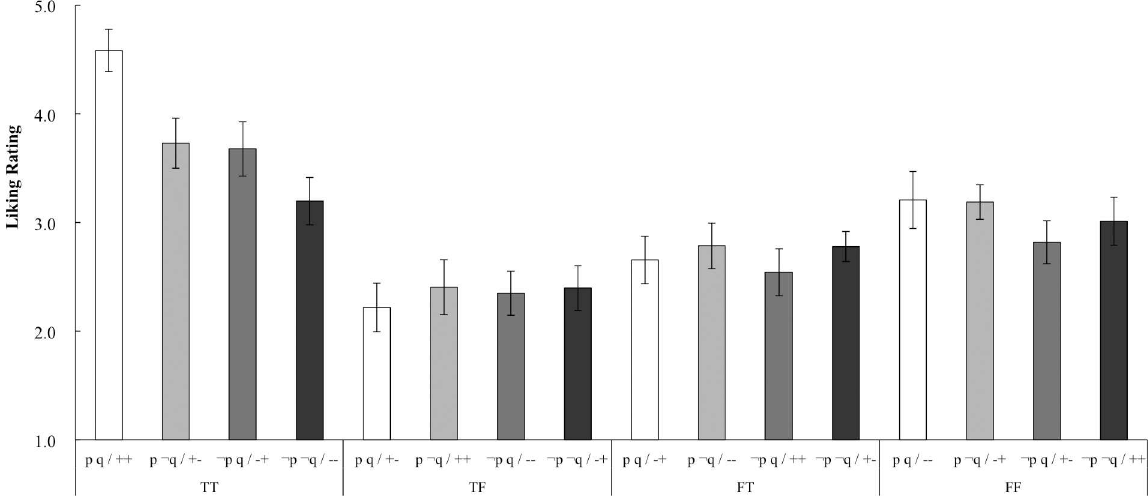
Fig 3. Mean Liking Ratings and Cousineau-Morey DifferenceAdjusted 95% Confidence Intervals for the Four Targets and Matching in Experiment 2. Note: ++ doublematching, +- antecedent matching, -+ consequent